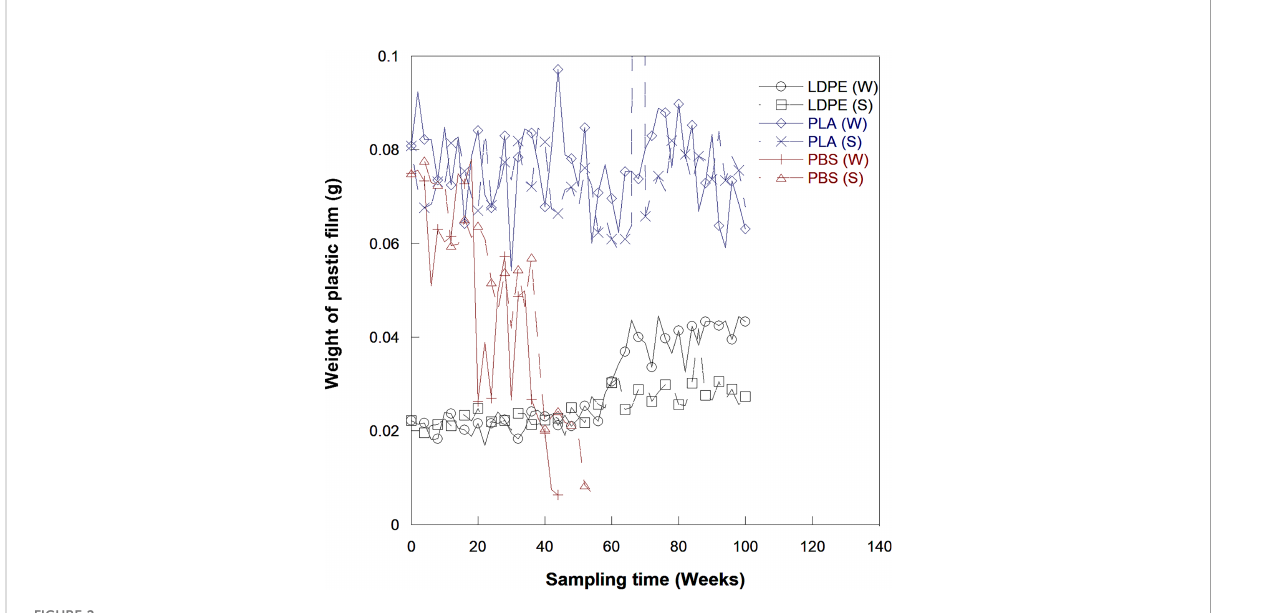
FIGURE 2 Weight of the sample blown fi lms after having been dried in an